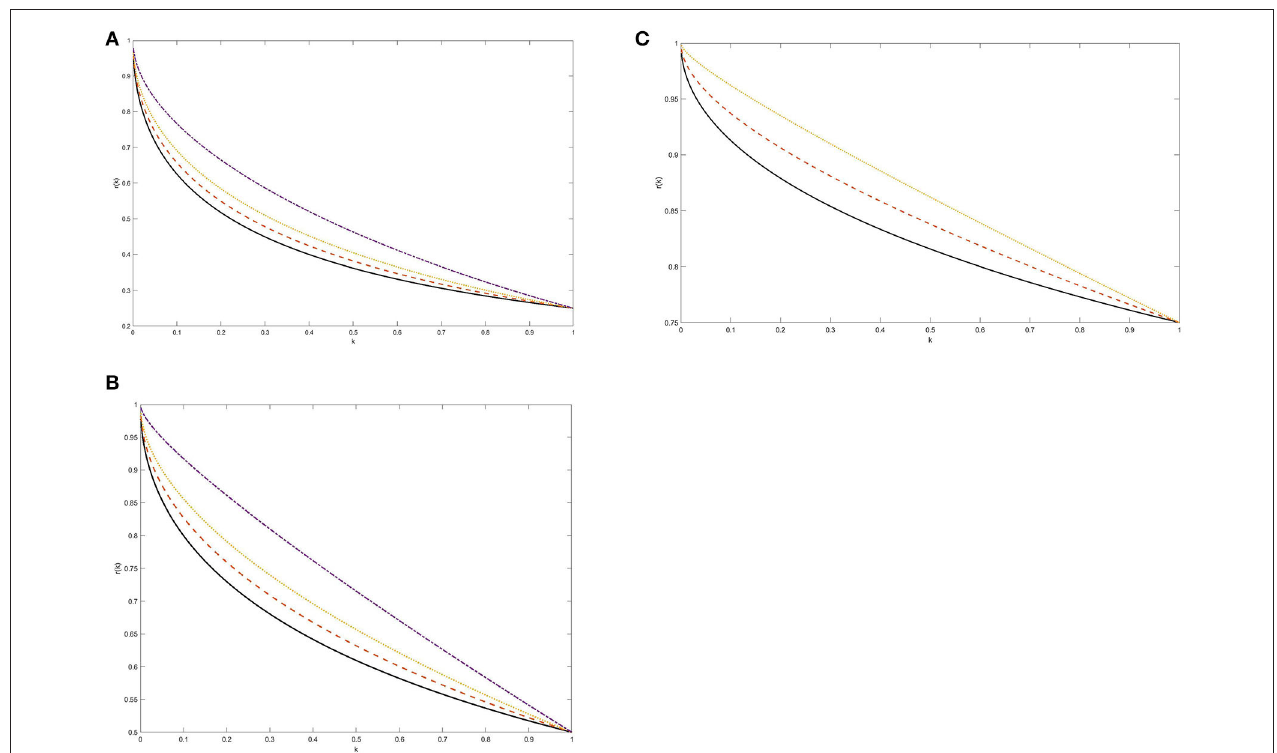
FIGURE 1 | (A–C) The weight of the faster growing subpopulation as a function of tumor shrinkage factor k: Exponential kinetics. The weight r(k) was computed from Equations 4 and 5 at the time when the size of a re-growing tumor reaches its pre-treatment level. Two surviving tumor subpopulations were assumed to grow according to exponential laws with unspecified net rates λ and 2 λ . The post-treatment growing subpopulation was assumed either balanced ( p symmetrically unbalanced ( p 0.25, A and p 0.75, C ). The following values for the weight of the quiescent cancer cell population were adopted, assuming q < 1-p: = = q 0 (solid line), q 0.1 (dashed line), q 0.2 (dotted line), and q 0.4 (dashed-dotted line). See section Methodology and Proof of Principle for more = = = =